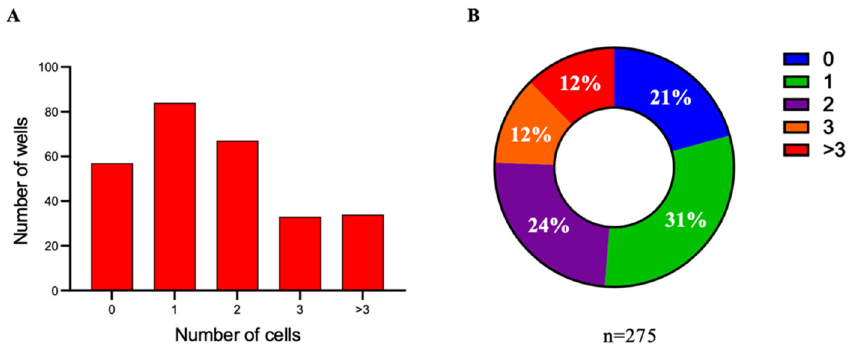
Figure 7. ( A ) The number of cells/well for n = 275 wells. ( B ) Percentage (%) of empty microwells, 1 cell/well, 2 cells/well, 3 cells/well, and more than 3 cells/well (Figure S2).